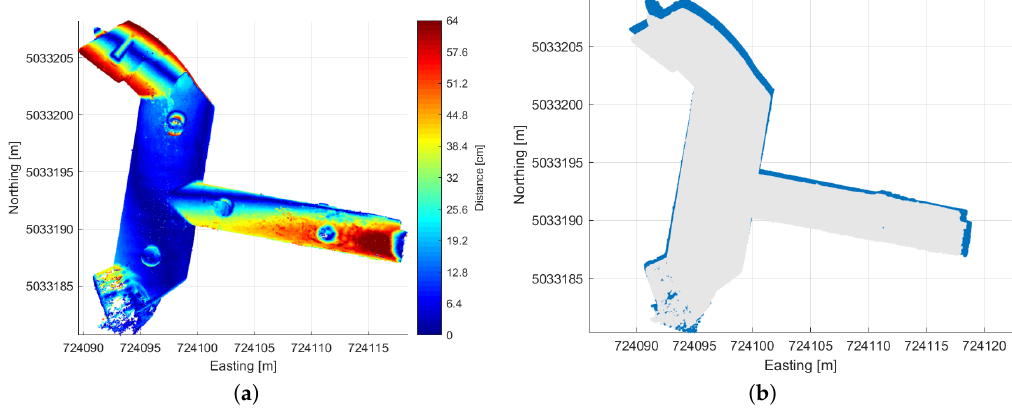
Figure 10. ( a ) Map of point-to-point distances between TLS and photogrammetric point clouds in the WGS84 UTM32 coordinate system. UWB anchor positions surveyed with Leica TCR 702 Total Station. ( b ) Top view of the two georeferenced point clouds (TLS (blue) and the photogrammetric ones